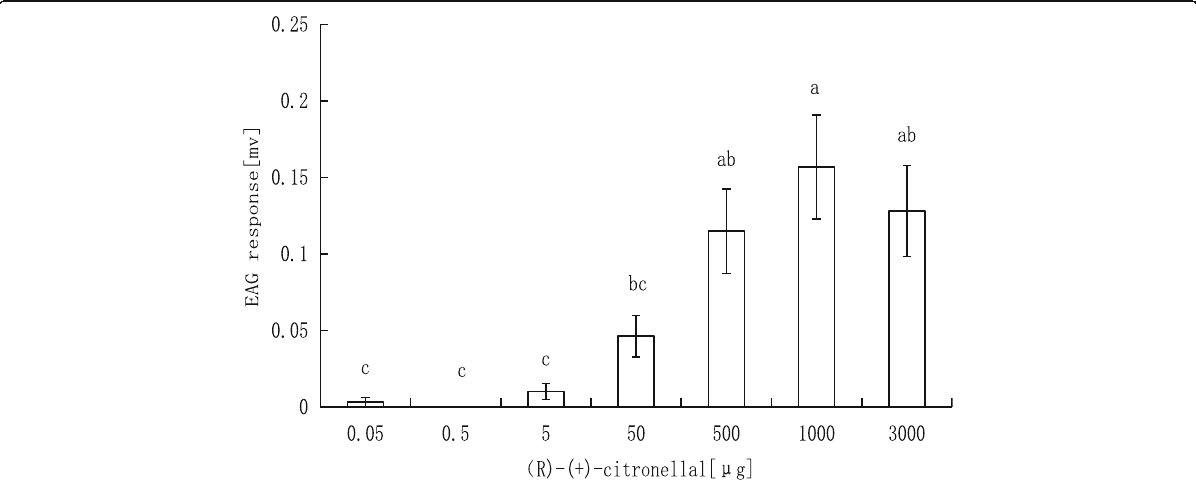
Fig. 4 Responses of A. bungii antennae to different quantities of ( R )-(+)-citronellal. Data are means ± SE. Values followed by different lowercase letters in the columns are significantly different to each other at P < 0.05, Tukey ’ s multiple comparison